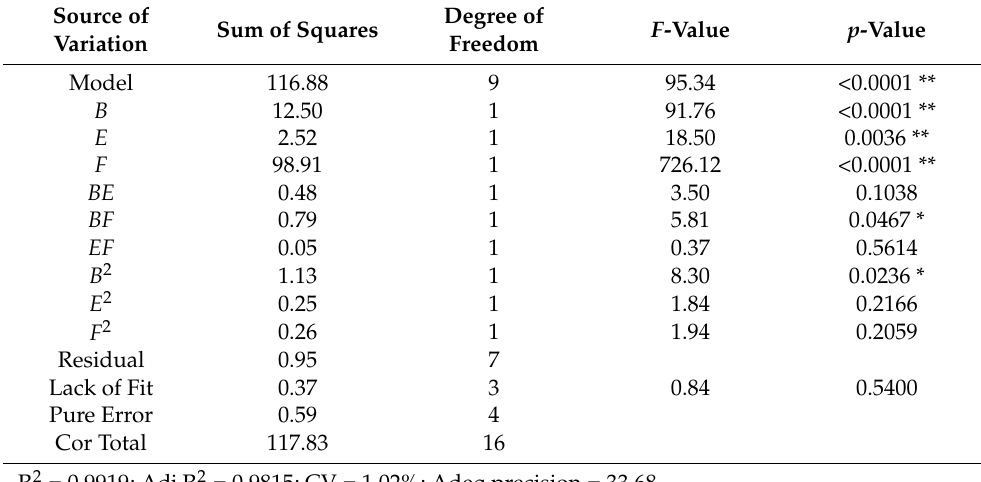
Table 6. Variance analysis of Box–Behnken test